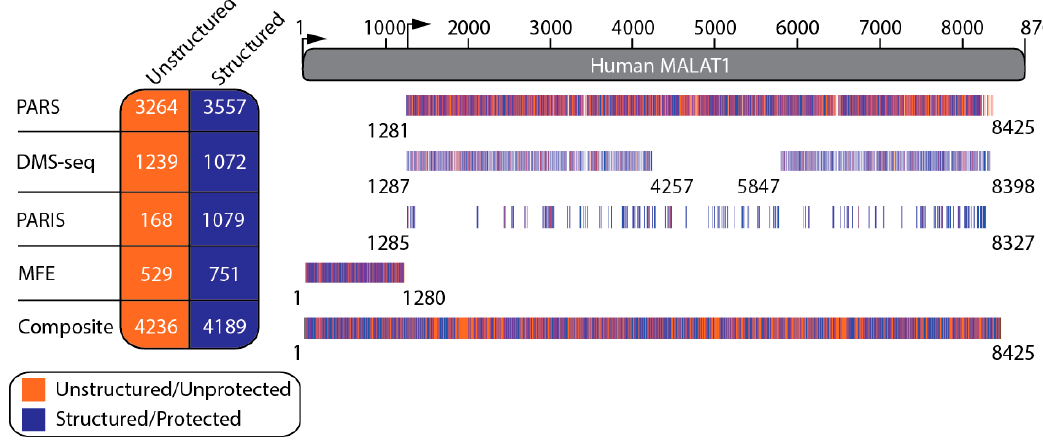
Figure 1. Overview of structural assignments for each nucleotide in human MALAT1. PARS data [21], DMS-seq data [22], PARIS data [26,27], and minimum free energy (MFE) calculations [29,32] were collectively used to construct a composite structural landscape for each nucleotide in MALAT1 (nts 1–8425). The orange lines represent individual nucleotide positions that were designated as unstructured based on PARS datasets and MFE calculations and unprotected adenosine or cytidine residues based on the DMS-seq dataset. The blue bars represent individual nucleotide positions that were designated as structured based on PARS datasets and MFE calculations and as protected adenosine or cytidine residues based on the DMS-seq dataset. The number of nucleotides that are unstructured/unprotected (orange column) or structured/protected (blue column) for PARS, DMS-seq, PARIS, MFE, and the composite model are listed in the table to the left. PARIS data that overlap with unstructured or structured regions of the MALAT1 transcript are presented as either orange or blue, respectively. The short arrow represents the transcription start site of the full-length malat1 gene (nts 1–8708), while the tall arrow represents the transcription start site of the major variant of the malat1 gene (nts 1284–8708).